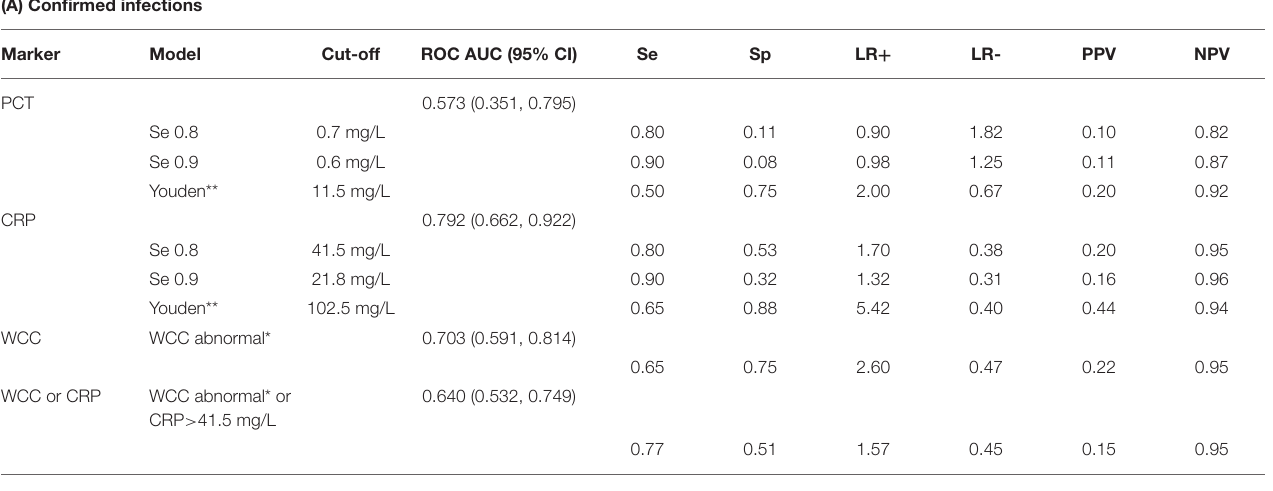
TABLE 2 | Diagnostic accuracy of Procalcitonin (PCT), C-reactive protein (CRP), and White Cell Count (WCC) to diagnose infection on ECMO. (A) Confirmed